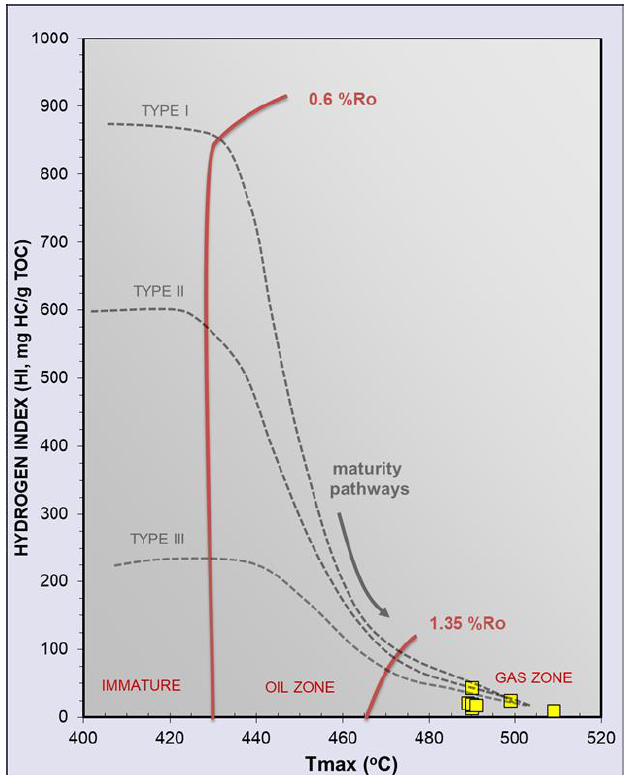
Figure 6. Hydrogen index (HI) vs. Tmax (maximum temperature in °C at S2 peak of Rock – Eval pyrolysis) diagram (based on Espitalié et al. [18] and Espitalié [19]). For this graph, samples